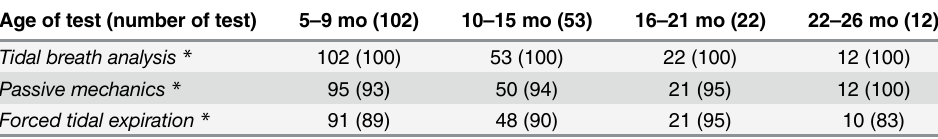
Table 2. Number and success rate of 189 lung function tests on 126 infants (50%